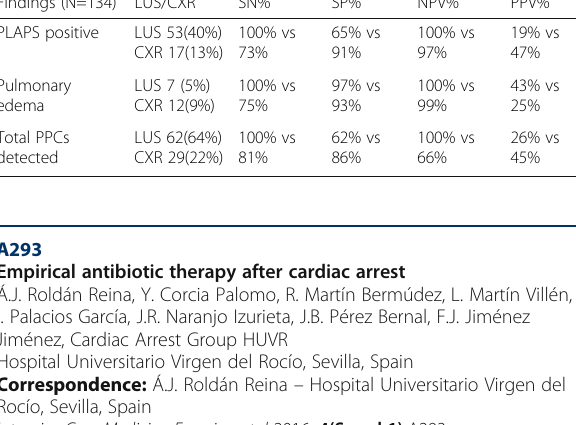
Table 88 (abstract A292). PPC's identified by LUS and CXR related to clinical relevant PPC's for which attending physician initiated therapy Findings (N=134) LUS/CXR